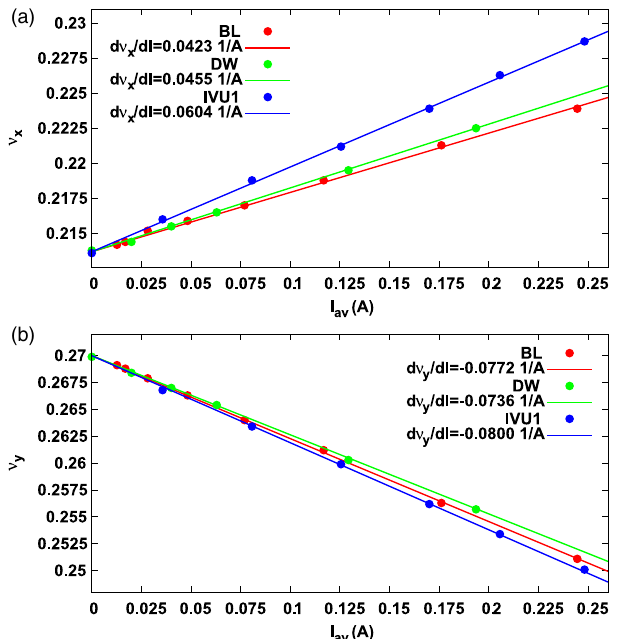
FIG. 6. Horizontal (a) and vertical (b) betatron tune shifts versus average current for lattices with local β x ¼ 21 m.